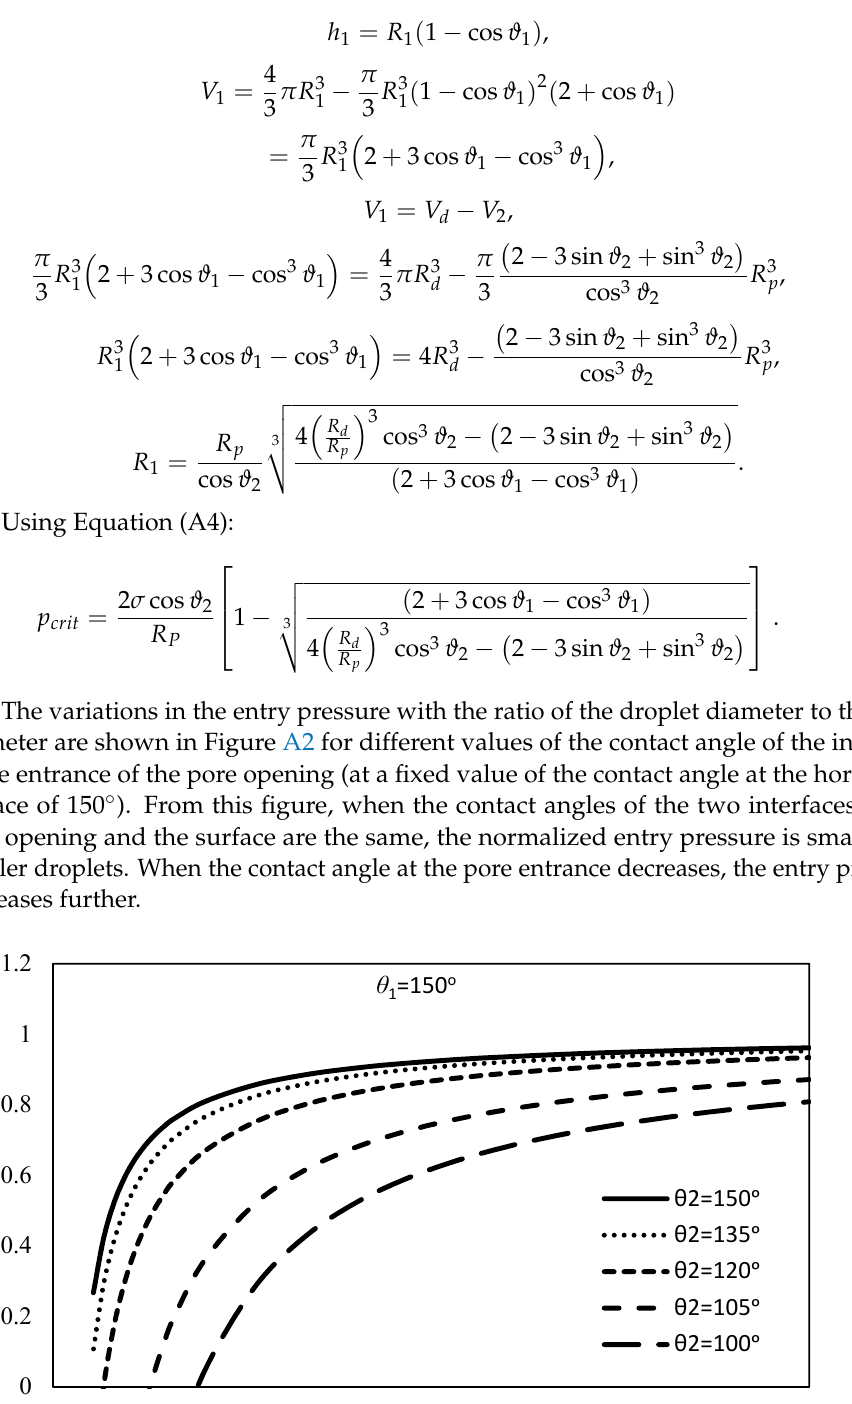
(cid:0) (cid:1) d p diameters. From